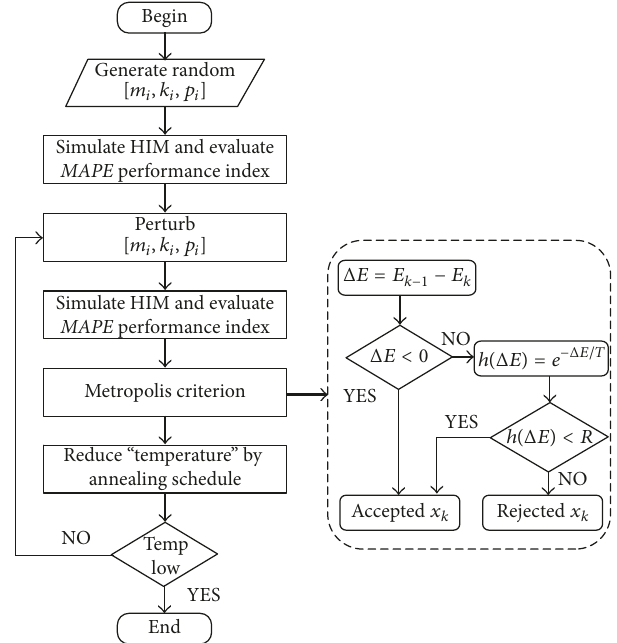
Figure 1: Algorithm for optimal tuning of hybrid modeling param- eters based on simulated